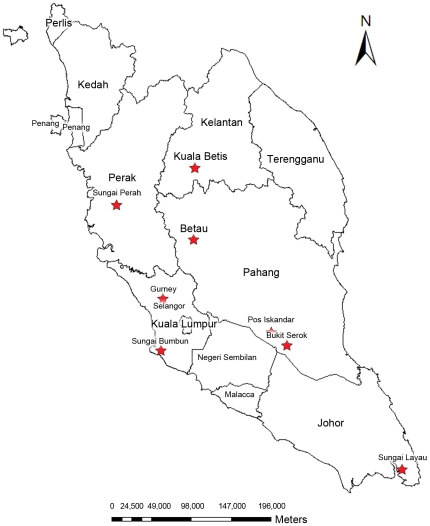
Location of the study areas in West Malaysia (indicated by star symbol).